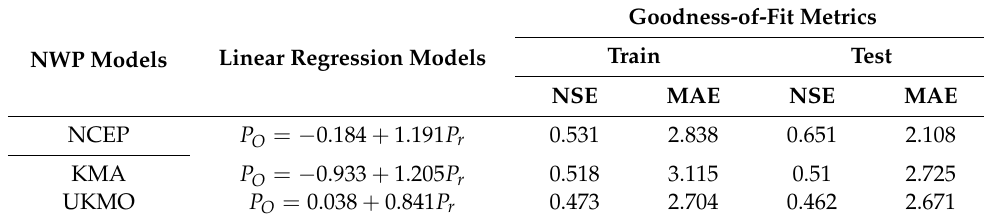
Table 7. Linear regression models for post-processing the ensemble precipitation forecasts.